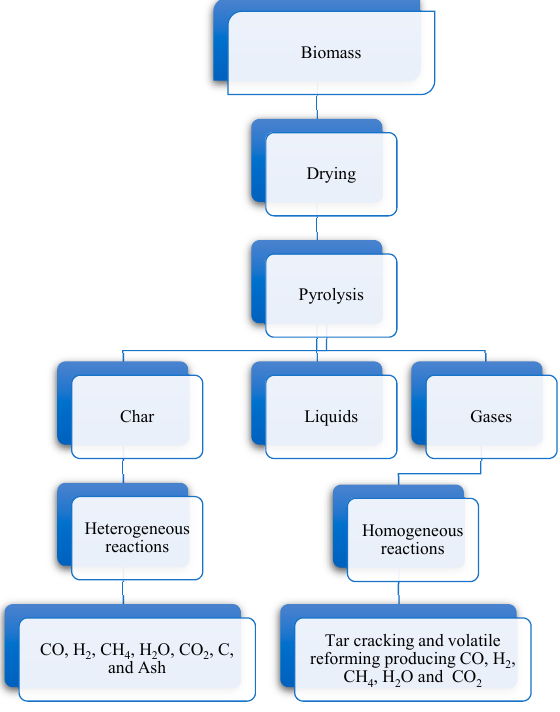
Figure 1. Possible routes for gasification. Adapted from [6].